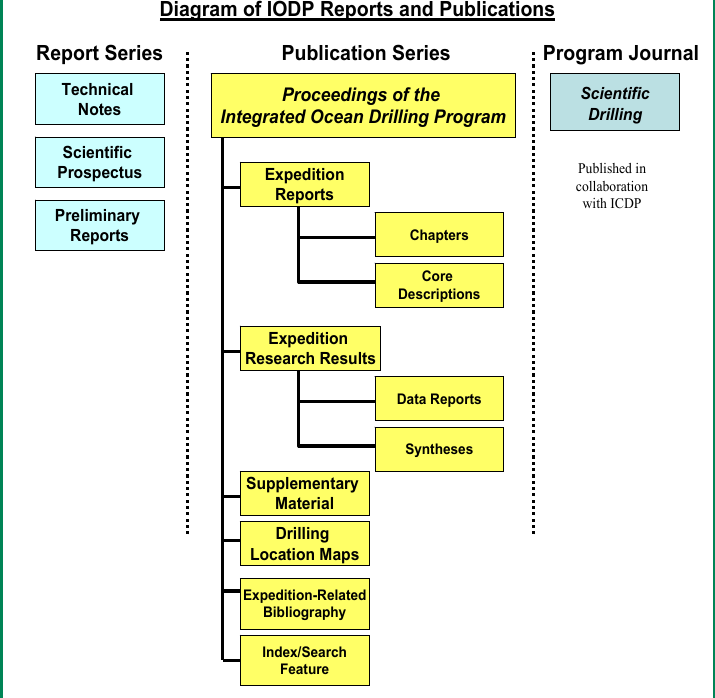
Figure 1. Publication structure in IODP consisting of the report series, publication series, and program journal Scientific Drilling